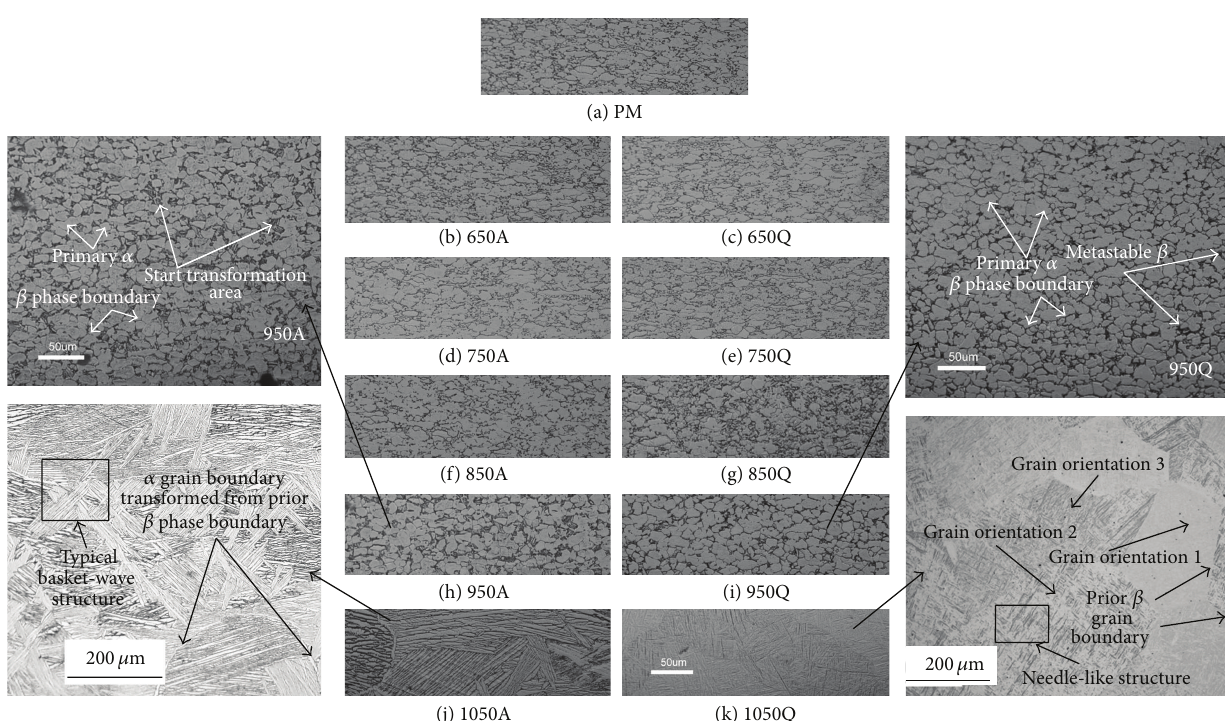
Figure 3: Optical microstructure of AR material and heat-treated Ti6Al4V. The number indicates the heat-treatment temperature. “A” indicates annealing (furnace-cooled) and “Q” indicates quenching.